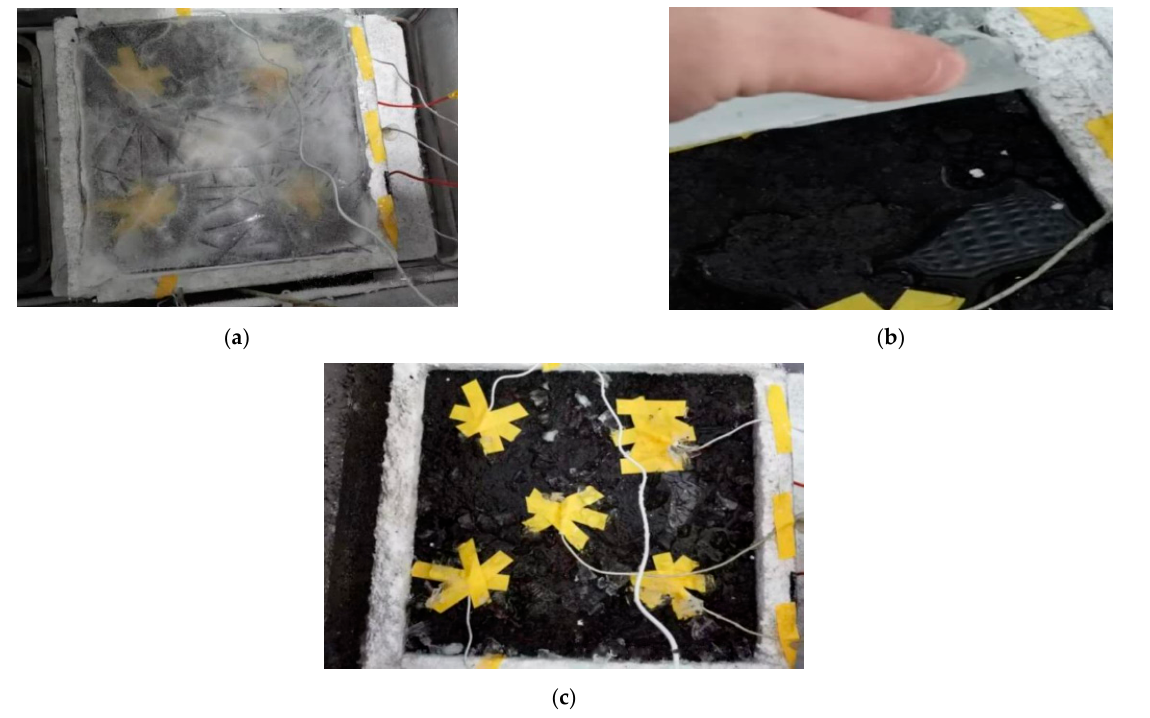
Figure 18. Ice melting test diagram with insulation layer. ( a ) On-test; ( b ) Melting separation; ( c ) Ice melting end.